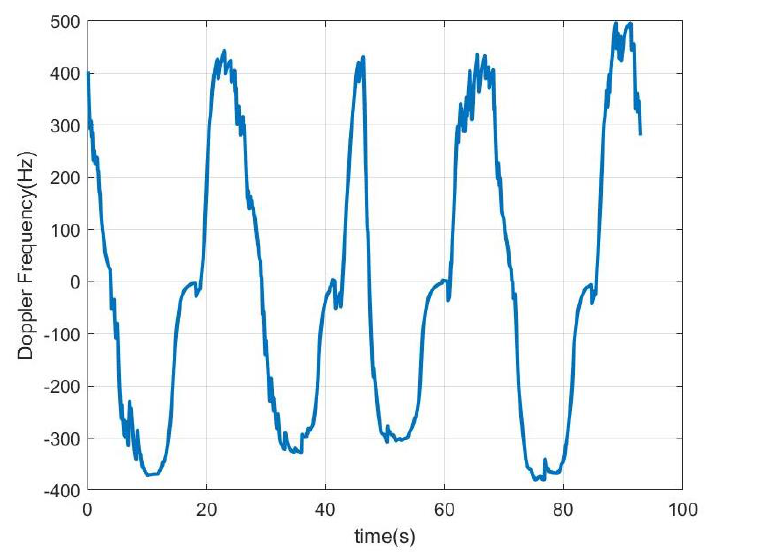
Figure 21. Measurement for a moving scooter sending Barker codes with length 13: Doppler fre- quency of the scooter